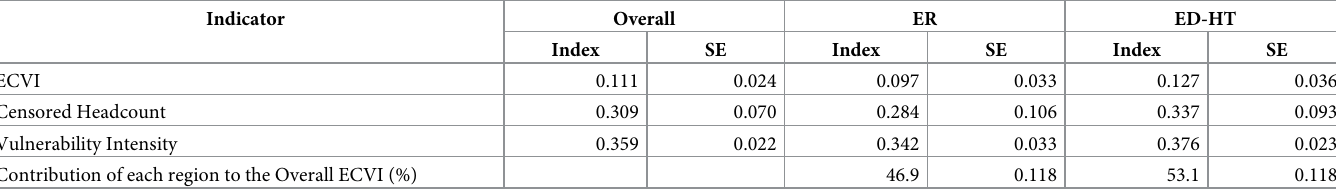
Table 2. ECVI, Censored Headcount and Vulnerability Intensity for the overall and each homoclimatic region (k = 0.25).